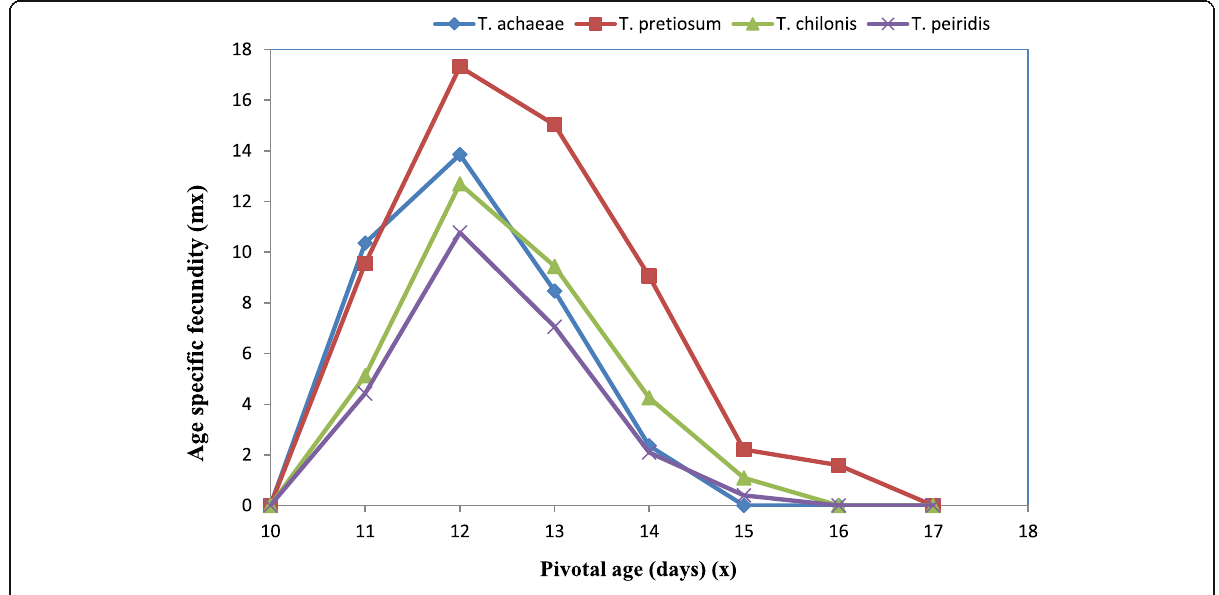
Fig. 2 Comparison of age-specific fecundity (m x ) of Trichogramma spp. on Tuta